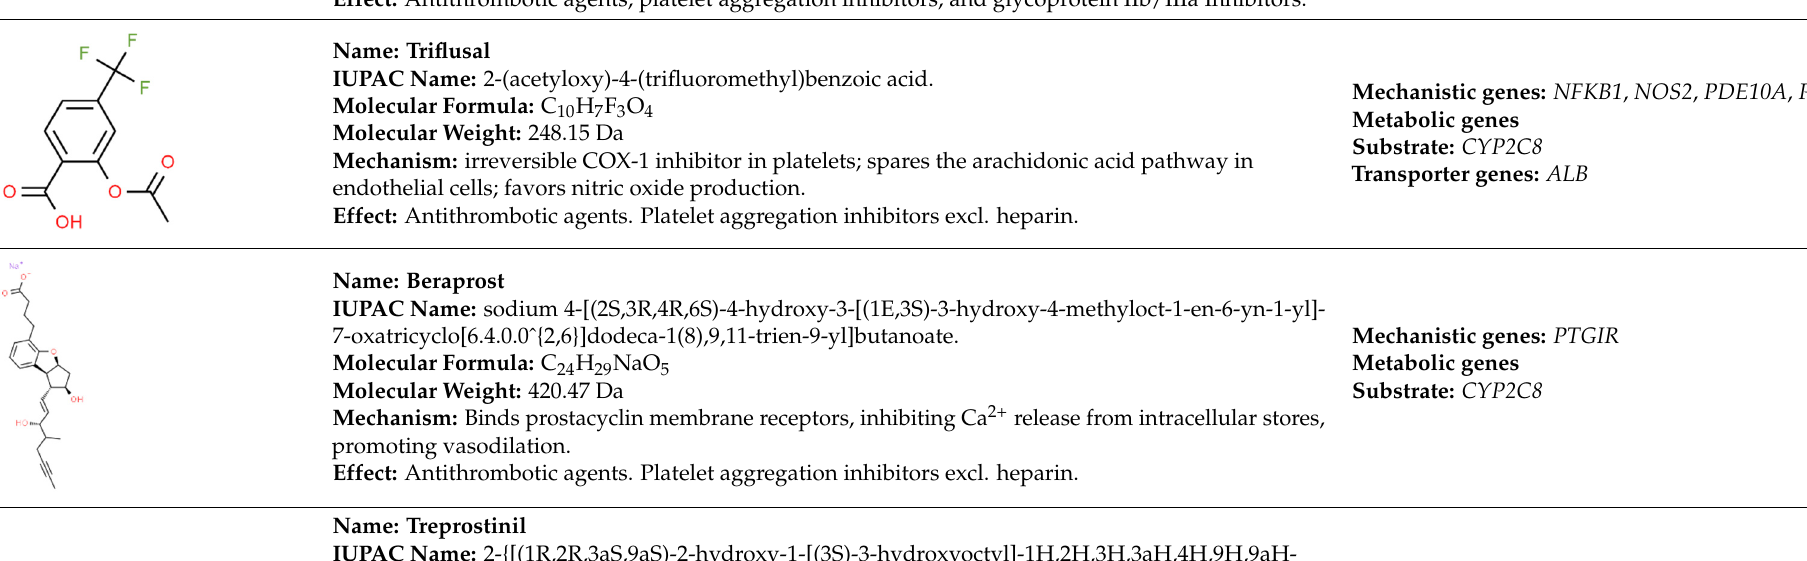
Mechanism: Prostacyclin vasodilator; binds to the prostacyclin receptor inducing vasodilation of pulmonary and systemic arterial vascular beds, inhibits platelet aggregation and inflammatory cytokine